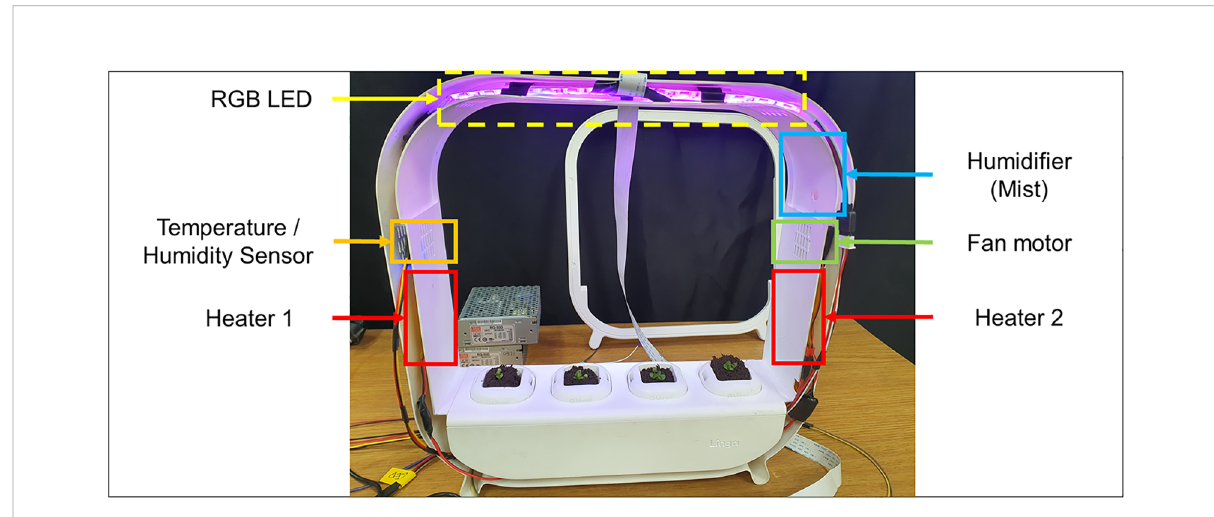
FIGURE 4 Composition of the main components in the